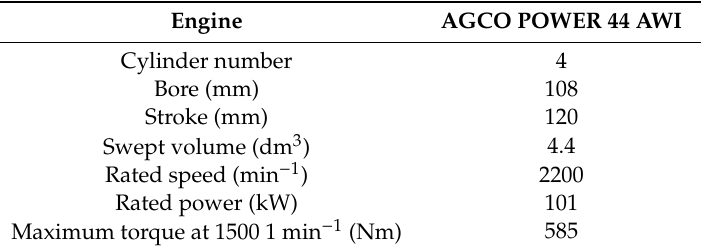
Table 2. Test engine specification.